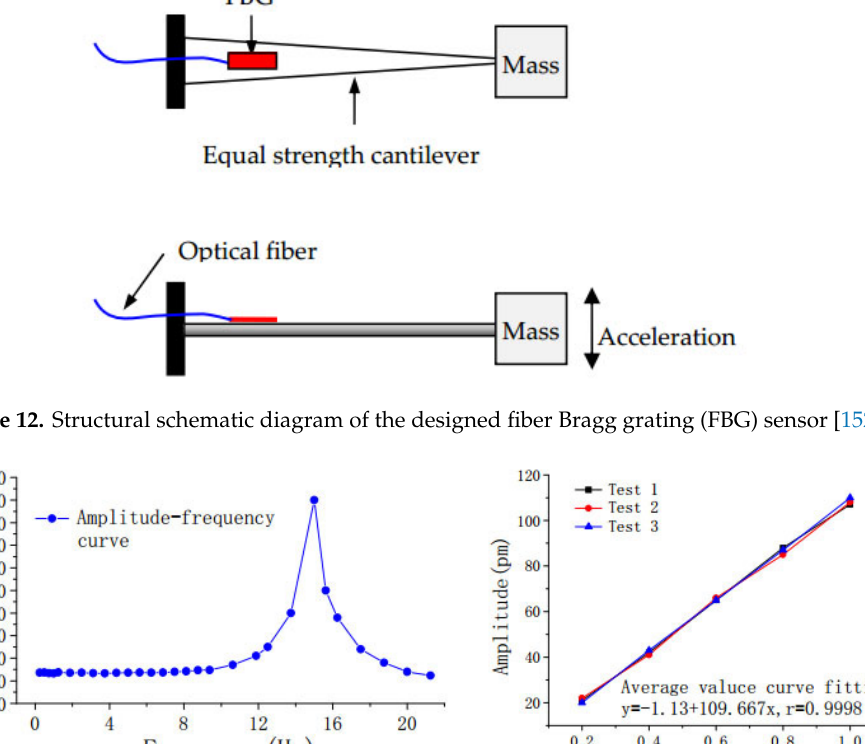
Figure 14. Suspension cable force distribution data measured by fiber Bragg grating (FBG) sensors: ( a ) south side suspension cables; ( b ) north side suspension cables [152] . 4.2. Buildings In 2019, Aleksander Wosniok et al. [153] used DFOS to study the effect of static traffic loads on the slight deflection of existing bridge concrete structures. In this work, they tested the load on Amsterdambridge705 by using two 36-ton trucks parked at multiple locations on the bridge to record the longitudinal strain of the FOS embedded inside the bridge. The experimental results proved that the monitoring system supervised that the 93.9-m-long part of the optical fiber had detected a small elastic strain in the range of as low as 2 μ m/m with a spatial resolution of 20 cm. Subsequently, Dong Yang et al. [154] proposed a deflection measurement for bridges based on the plastic optical fiber sensing (POFS) system. As shown in Figure 15, the system consists of three parts: